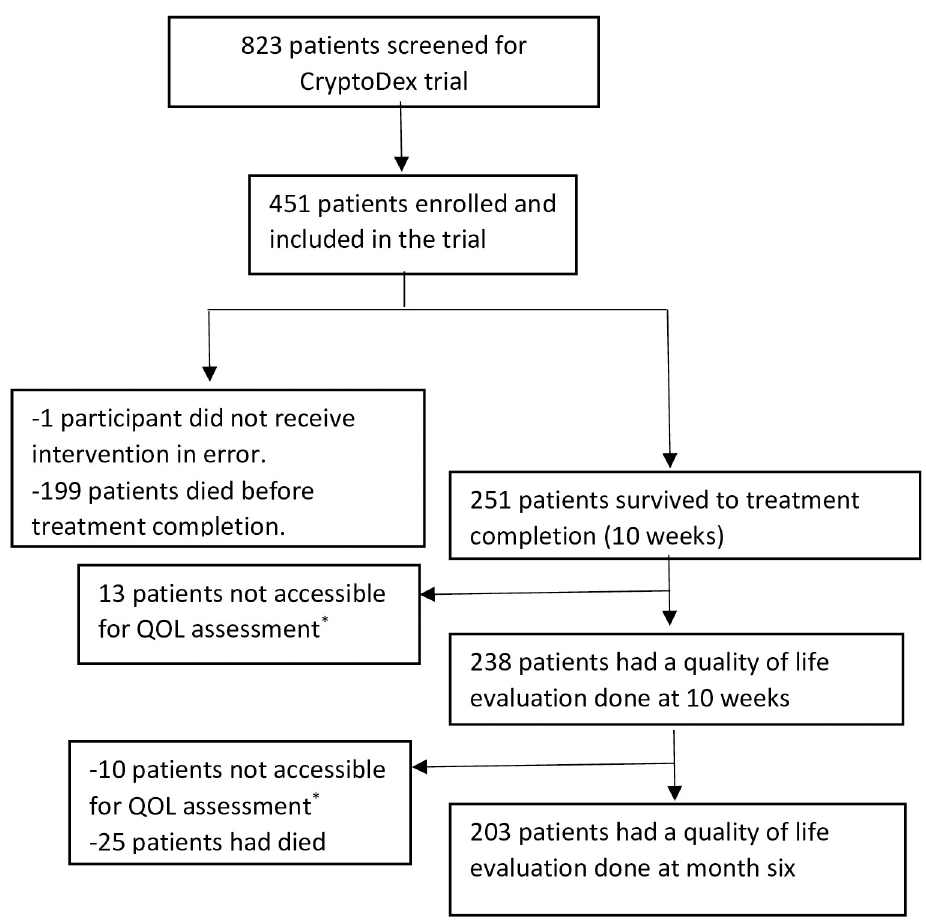
Fig 1. Flow diagram showing participants enrolled in CryptoDex trial who had quality of life evaluations done. � Patients were not able to come to clinics to have QOL assessment.